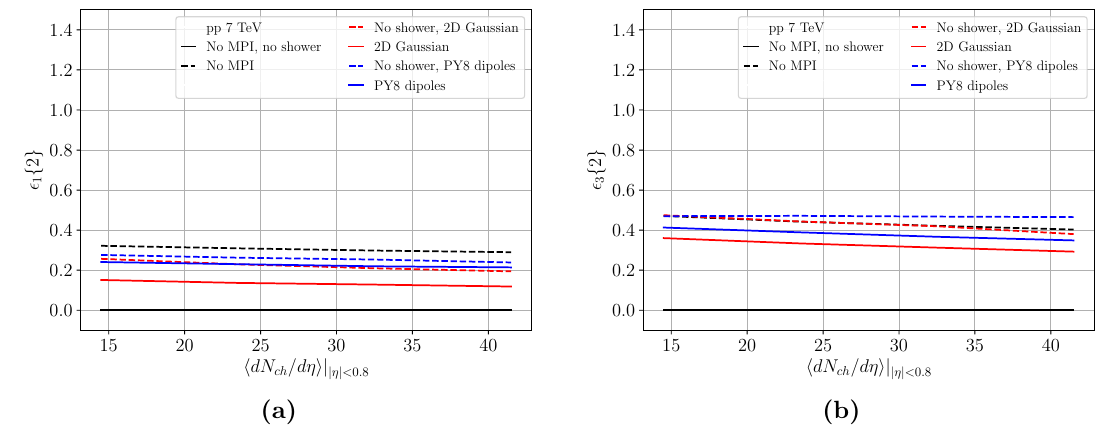
Figure 20. (cid:15) 1 ; 3 f 2 g shown for di(cid:11)erent MPI vertex assignments with and without the shower smearing.